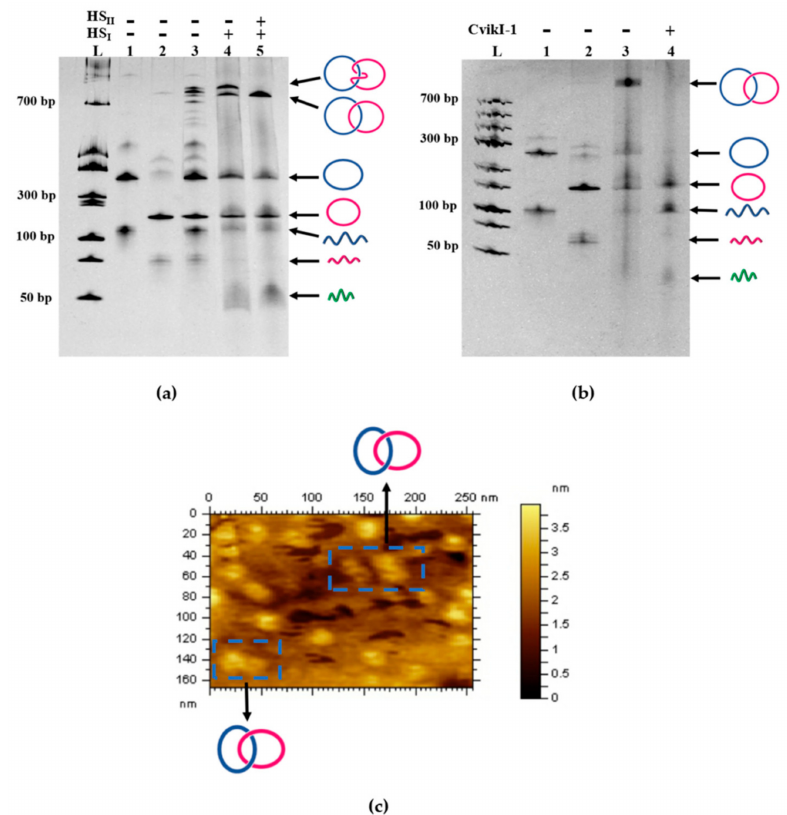
Figure 1. Analysis of a single-stranded DNA (ssDNA) catenane prepared from L DNA α (75 nt) and L DNA β (63 nt) by 14% denaturing polyacrylamide gel electrophoresis (dPAGE). In lane 5 in ( a ), the catenane was fabricated by using two holder strands (46 and 19 nt). [ L DNA α ] = [ L DNA β ] = [HS I ] = [HS II ] = 0.5 µ M. After the formation of the quasi-catenane intermediate, T4 DNA ligase